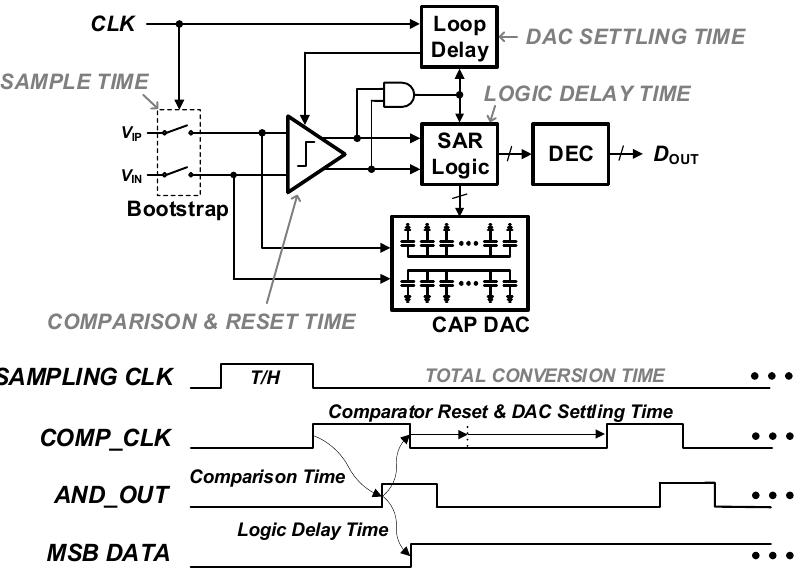
Figure 1. A structure and timing budget of the asynchronous SAR ADC.